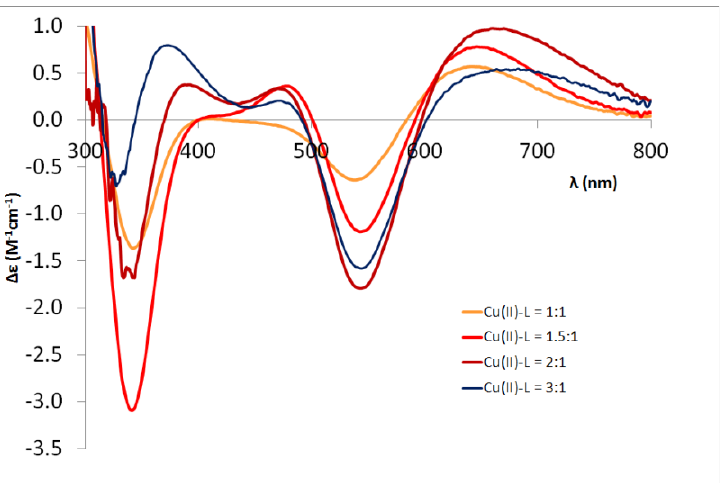
Figure 7. The CD spectra of the Cu(II)-Ac-HFHAHFH-NH 2 system in function of the Cu(II)-L ratio (pH = 10.5).